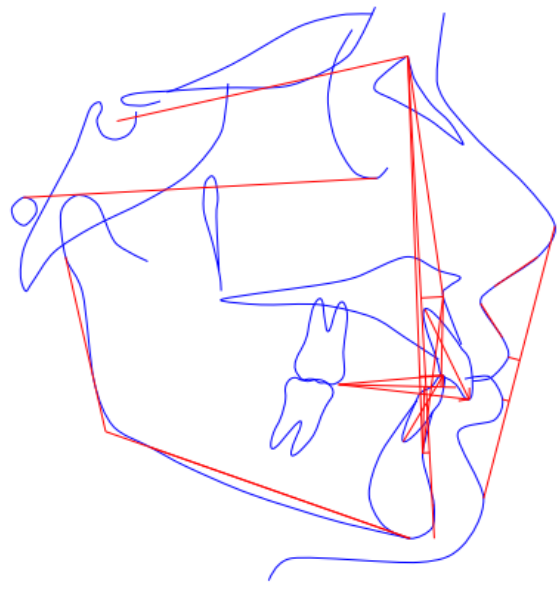
Figure 17. Pre-treatment cephalometric tracing of case number 2.